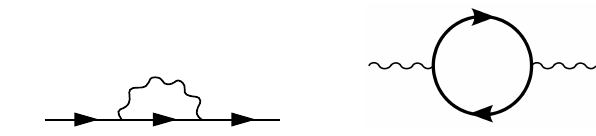
Figure 22. Feynman diagrams for self-energy ( left ) and vacuum polarization ( right ).